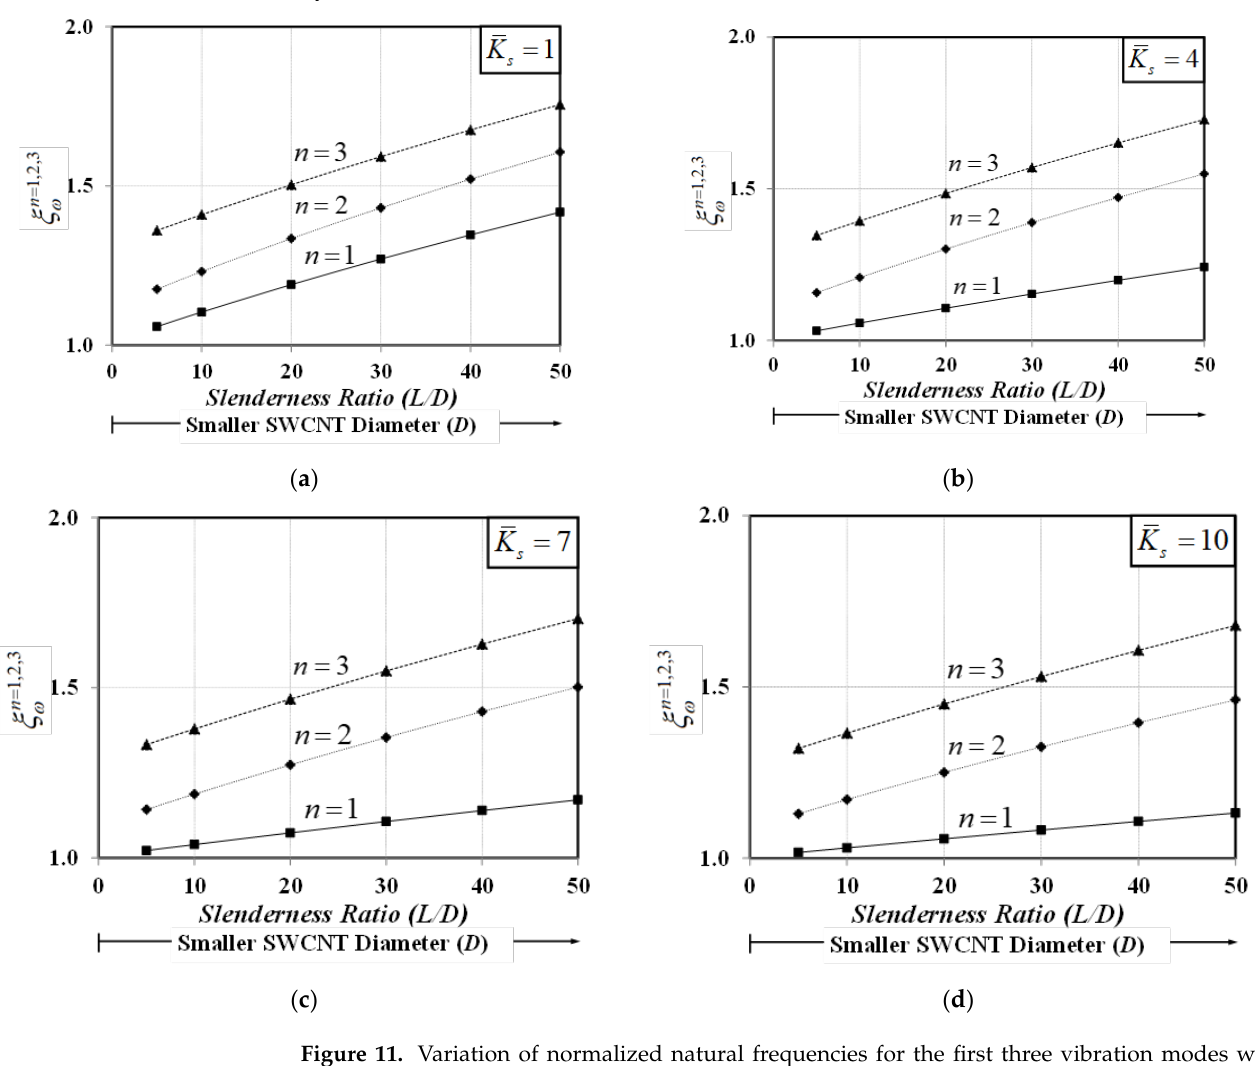
Figure 11. Variation of normalized natural frequencies for the first three vibration modes with SWCNT diameter for various elastic substrate stiffnesses: ( a ) K s = 1, ( b ) K s = 4, ( c ) K s = 7, and . ( d ) K s =